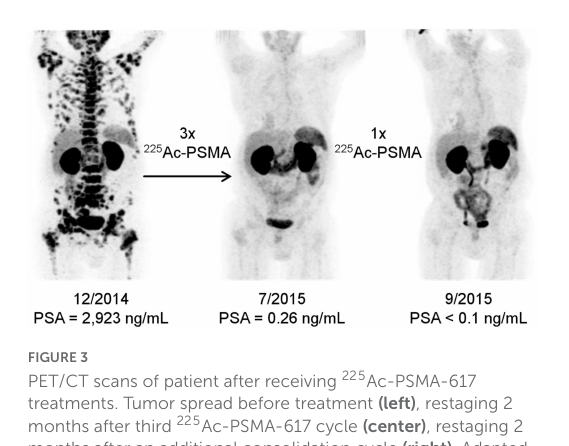
FIGURE3 PET/CT scans of patient after receiving 225 Ac-PSMA-617 treatments. Tumor spread before treatment (left) , restaging 2 months after third 225 Ac-PSMA-617 cycle (center) , restaging 2 months after an additional consolidation cycle (right) . Adapted with permission from ref 53. Copyright 2016 Society of Nuclear Medicine and Molecular